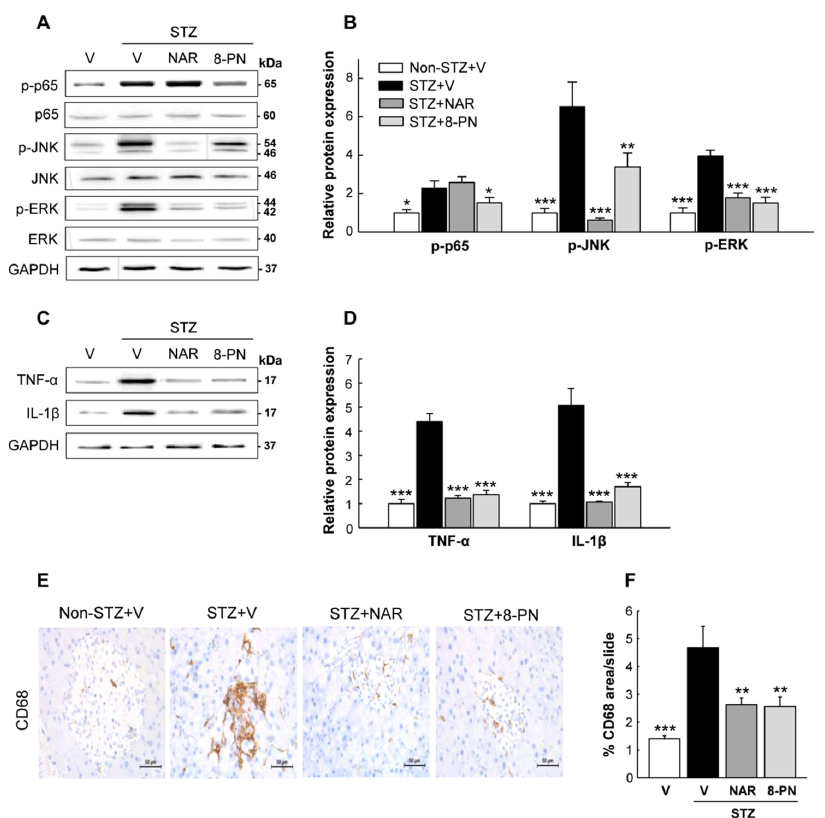
Figure 4. Inhibitory effects of naringenin and 8-PN on macrophage infiltration and inflammatory signaling in the pancreas. ( A ) Representative Western blot images of phospho-p65, p65, phospho-JNK, JNK, phospho-ERK, and ERK in the pancreas and ( B ) corresponding quantitative data. ( C ) Representative Western blot images of TNF- α and IL-1 β in the pancreas and ( D ) corresponding quantitative data. ( E ) Pancreas DAB staining for CD68 + macrophages ( × 400). ( F ) Quantitative data of macrophage infiltration were calculated by dividing the area of target signal by the total area. Data are shown as means ± SEM (n = 6 for ( A – D ) and n = 4 for ( E , F )). * p < 0.05, ** p < 0.01, *** p < 0.001 vs. STZ-vehicle group.